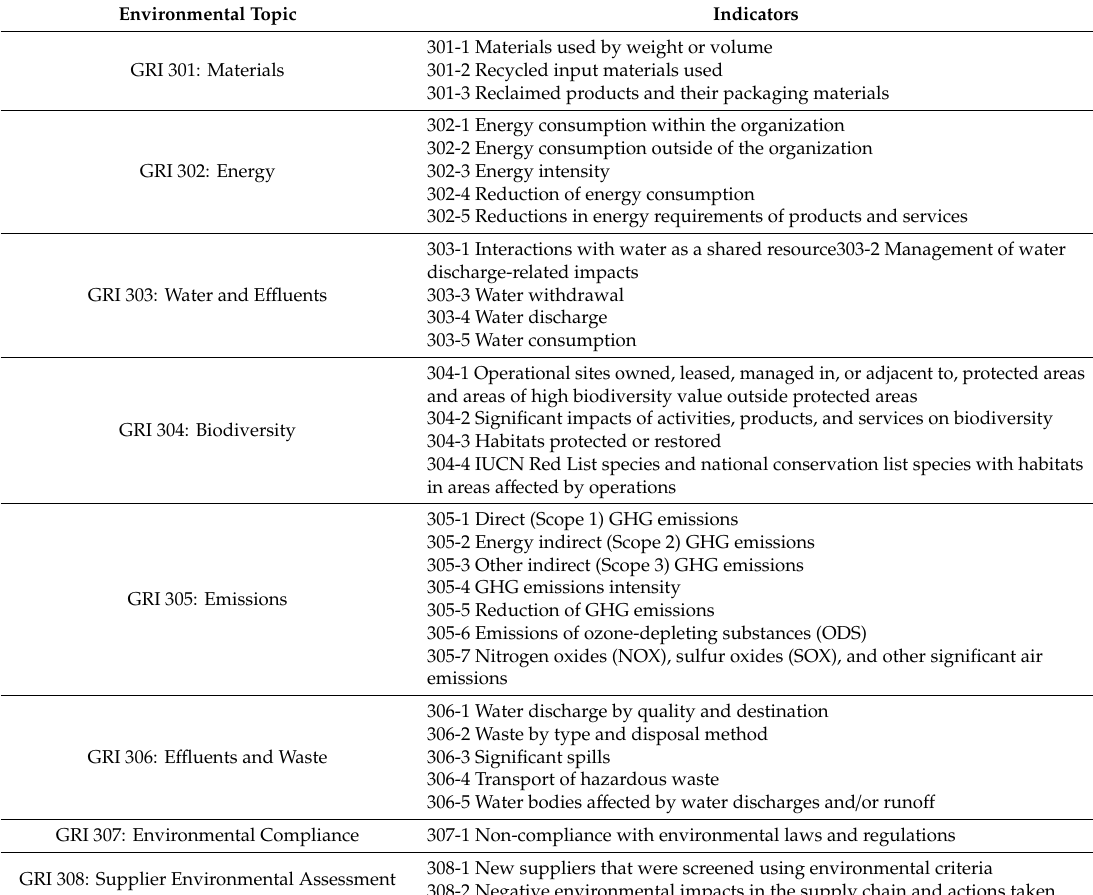
Table A1. Indicators of the GRI Environmental Standards G4–300